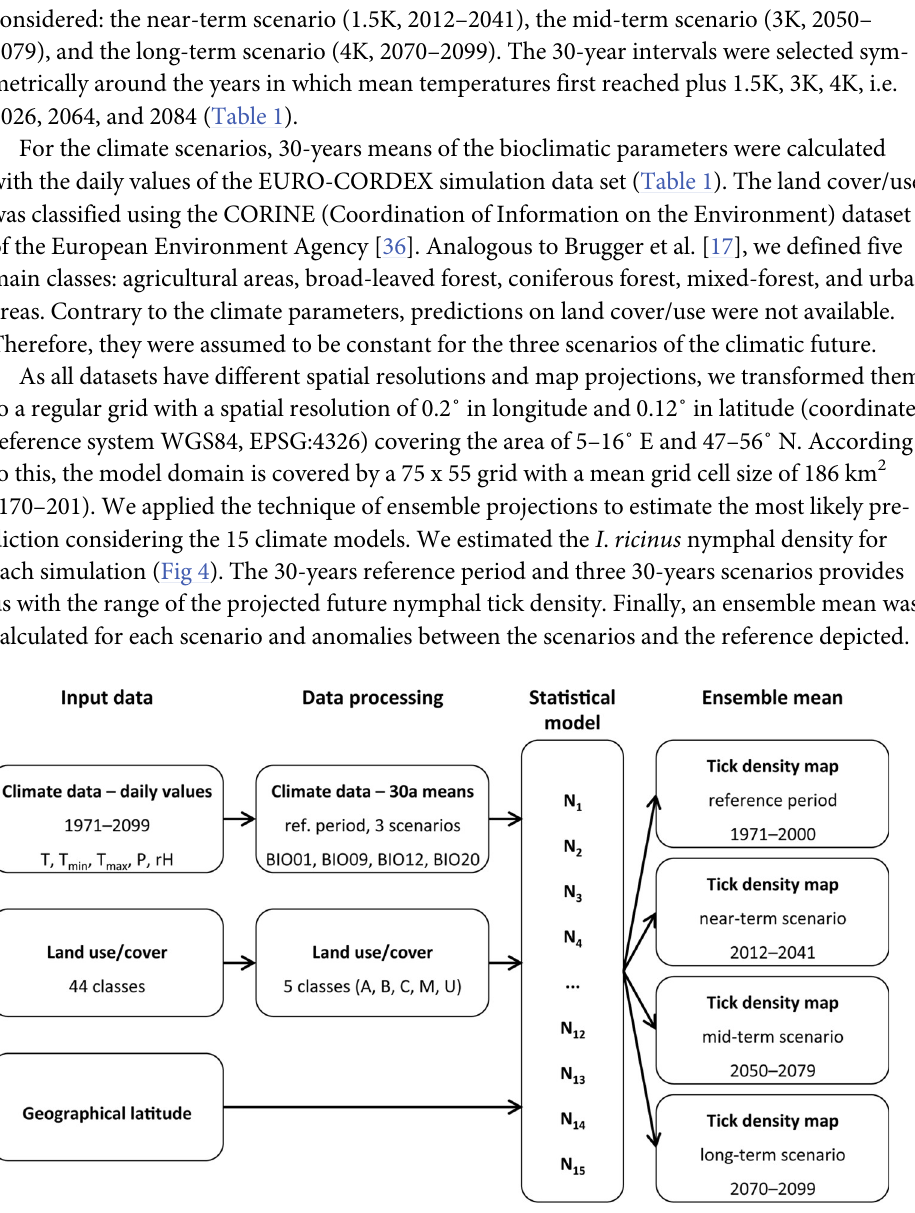
Fig 4. Flowchart of the data processing and implementation of the German-wide tick density